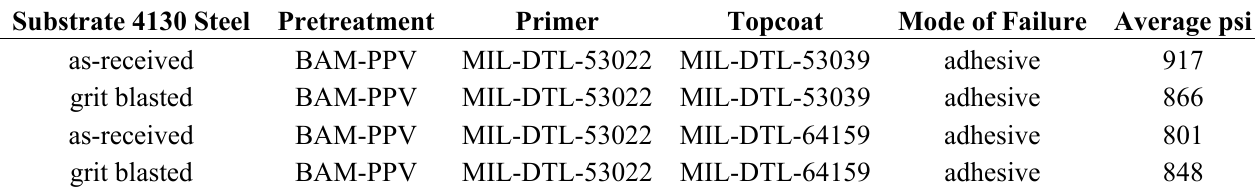
Table 3. Adhesion performance of BAM-PPV with MIL-DTL-53022 and CARC topcoats on 4130 steel coupons.